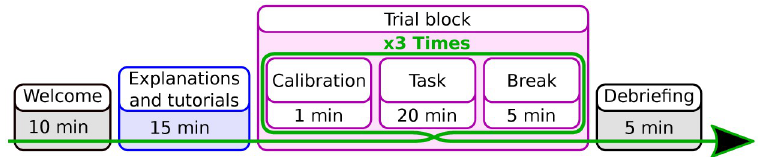
Fig 3. Timeline illustration of the experimental protocol of the